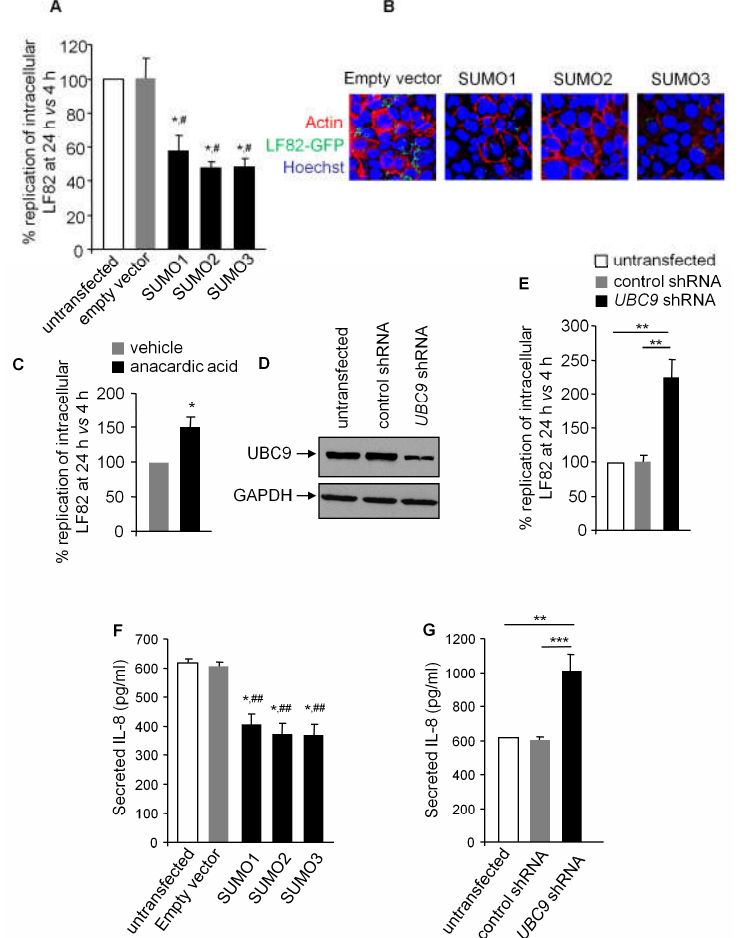
Figure 2. SUMOylation controls AIEC intracellular replication and AIEC-induced inflammation. ( A , B , F ) T84 cells were transfected with SUMOs-encoding plasmids before being infected with LF82 ( A ) or LF82-GFP ( B ). ( A ) Intracellular LF82 number was counted on LB agar plates and is presented as the ratio of intracellular bacteria at 24 h vs. 4 h post-infection, compared to untransfected condition, considered as 100%. ( B ) Representative confocal micrographs of cells infected with LF82-GFP (green) and immunolabeled for actin (red). Nuclei were stained with Hoechst (blue). ( C ) T84 cells pretreated with anacardic acid or vehicle were infected with the LF82 strain. LF82 intracellular number was counted on LB agar plates and is presented as the ratio of intracellular bacteria at 24 h vs. 4 h post-infection, compared to vehicle, considered as 100%. ( D , E , G ) T84 cells were stably transfected with UBC9 shRNA or an empty shRNA. ( D ) UBC9 expression level was analyzed by Western blot. ( E ) Untransfected or transfected cells were infected with the LF82 strain. LF82 intracellular number was counted on LB agar plates and is presented as the ratio of intracellular bacteria at 24 h vs. 4 h post-infection, compared to untransfected condition, considered as 100%. ( F , G ) T84 cells were infected with the LF82 strain. Secreted IL-8 amounts in cell culture supernatant were quantified by ELISA, 24 h post-infection. Data are means ± SEM of three replicates and are representative of three independent experiments. ( A , F ) (* p < 0.05; ** p ≤ 0.005) vs. untrasfected; ( # p < 0.05; ## p ≤ 0.005) vs. empty vector. ( C , E , G ) * p < 0.05; ** p ≤ 0.005; *** p ≤ 0.001.